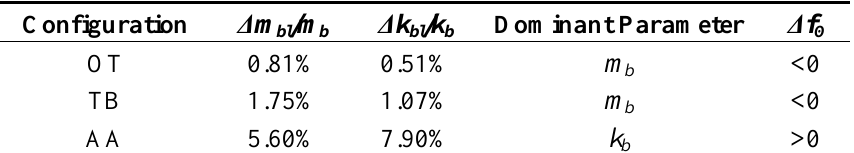
Table 3. The effect of the increasing of the thickness of the coating layer in different configurations on the resonance